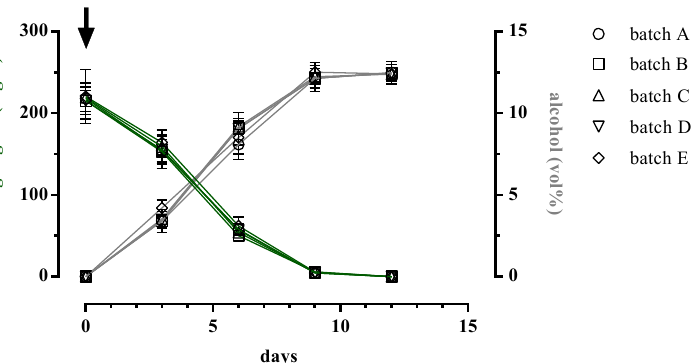
Figure 2. Consumption of reducing sugars and production of ethanol during the alcoholic fermentation of Fiano wine in accordance to several strategies of inoculum. Batch A, late co-inoculum strategy; Batch B, early co-inoculum strategy; Batch C, sequential inoculum non-pre-adapted strategy; Batch D, sequential inoculum pre-adapted strategy; Batch E, control.